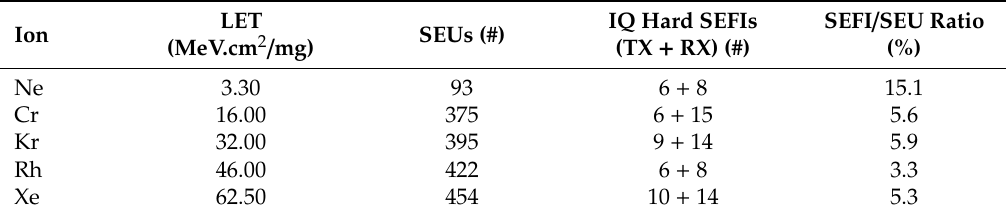
Table 3. SEU vs. Hard IQ SEFIs for DUT